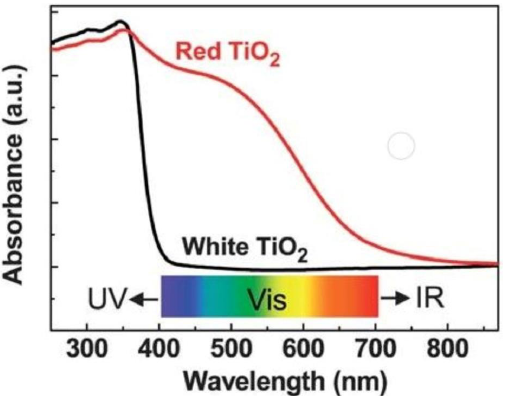
Figure 9. Comparison of UV-visible absorption of the white TiO 2 and red TiO 2 microspheres. Reprinted with permission from Ref. [197]. Copyright 2012, Royal Society of Chemistry. As evident, red titania microspheres possess much higher photo absorption ability than white titania in the visible light range. These microspheres have provided a gradient of absorption band gap energy from 1.94 eV (on their surface) to 3.22 eV (in their core) [179,197]. It has also been reported that red anatase TiO 2 -based materials could show an unusual visible-light absorption that is representative of new types of visible light absorp- tion bands of titania [198]. Thus, red titania-based photoanodes could be used for photo- electrochemical water splitting under visible-light irradiation [197,198]. Some other color- ful titania-based photoanodes, including blue TiO 2 , could be inactive in photoelectro- chemical water oxidation under visible-light irradiation [198]. 5. Conclusions and Perspectives The application of TiO 2 semiconductor nanoparticles for the photocatalytic decom- position of pollutants in wastewater has been considered in this study. Considering that TiO 2 has three different structures (anatase, rutile and brookite), their stability and photo- catalytic efficiency were compared. It should be noted that the band gap energy of these